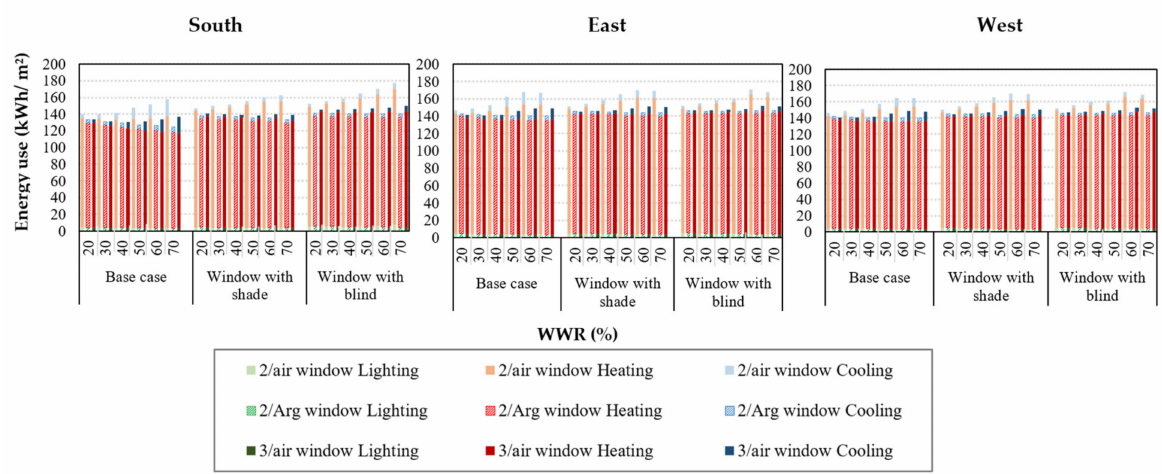
Figure 14. Lighting, cooling, and heating energy use as a function of WWR (%) for three window types (2/air, 2/Arg, and 3/air windows) for south, east and west orientations of buildings located in Temperate, fully humid climate with warm summer